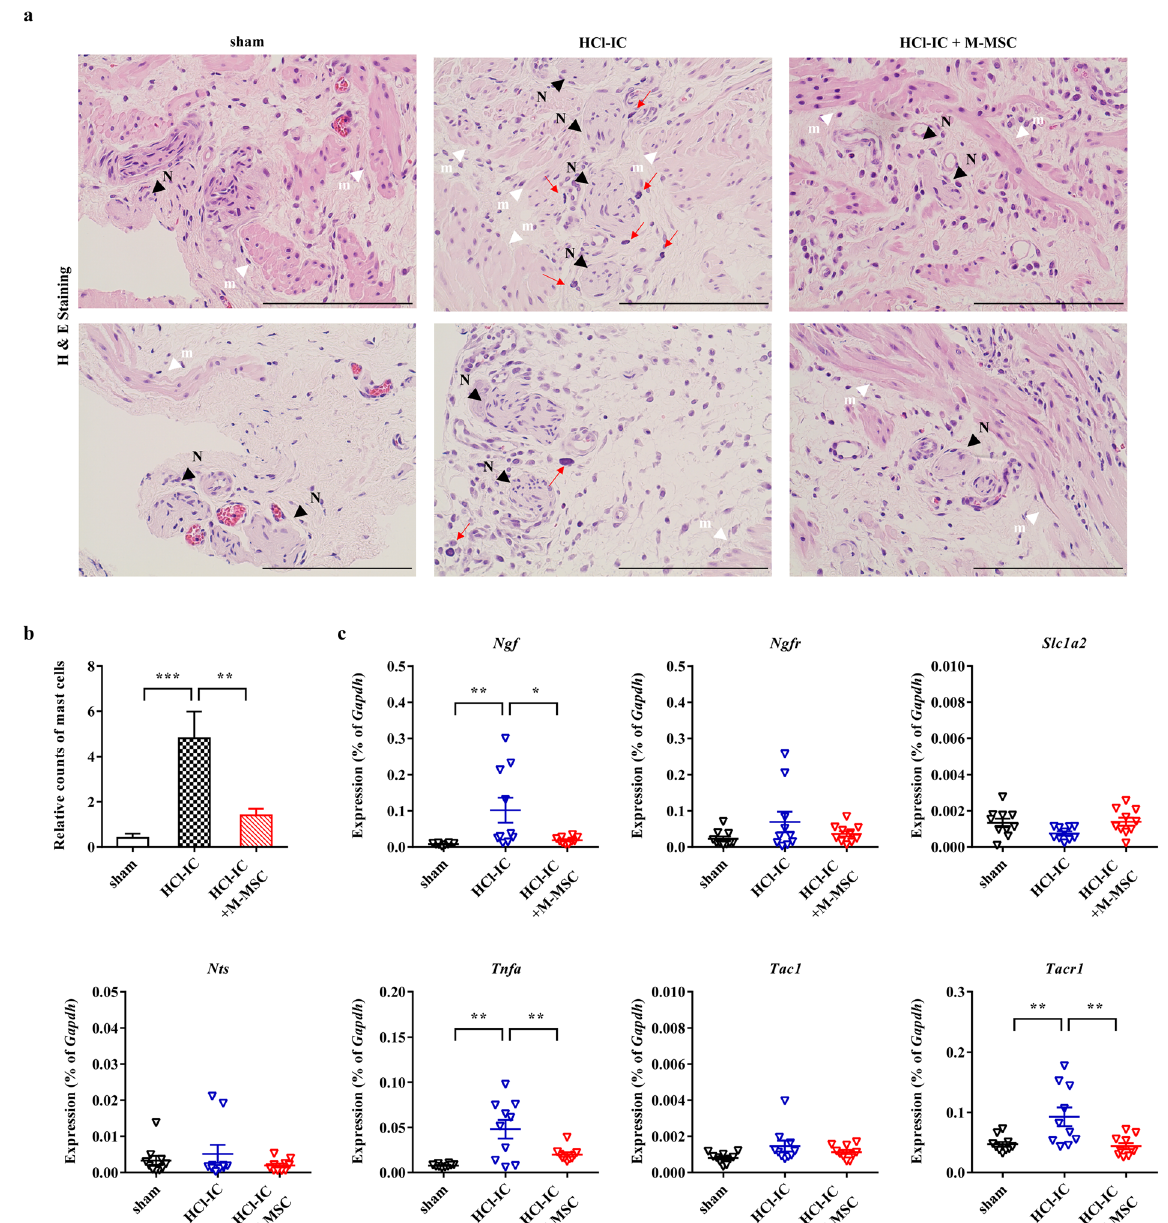
Figure 4. The effect of M-MSC injection on visceral hypersensitivty in HCl-IC model rats. ( a ) Hematoxylin and eosin (H & E) staining in the indicated bladder tissues (magnification × 200, scale bar = 100 μ m). Nuclei were stained with Mayer’s hematoxylin. Arrows indicate the infiltrated mast cells. N (black arrowhead) and m (white arrowhead) indicate the nerve and muscle fibers, respectively. ( b ) Quantification of the mast cells infiltrated around the nerve fibers (n = 15). ( c ) RQ-PCR analyses of expression levels of Ngf and the genes associated with visceral hypersensitiviy in the indicated bladder tissues 1 week after the injection of 1 × 10 6 M-MSCs or PBS vehicle into HCl-IC animals. Expression is presented as % Gapdh (n = 10). All data are presented as the mean ± SEM, * p < 0.05, ** p < 0.01, Bonferroni